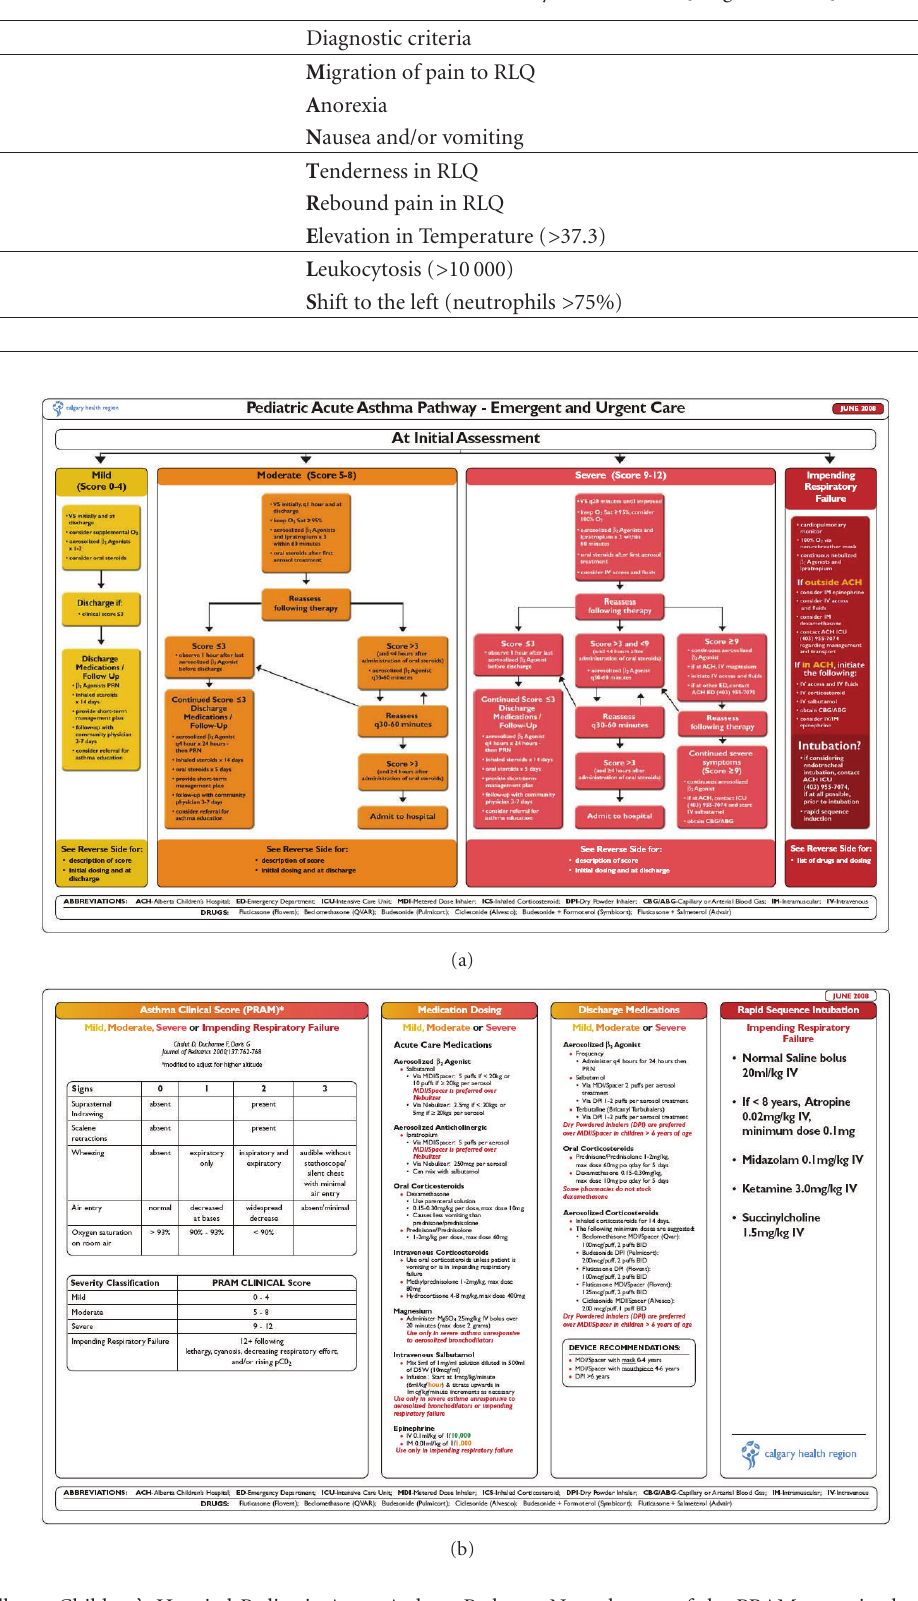
Figure 6: The Alberta Children’s Hospital Pediatric Acute Asthma Pathway. Note the use of the PRAM score in the Advanced Nursing Directive to guide administration of systemic steroids, beta agonists, and